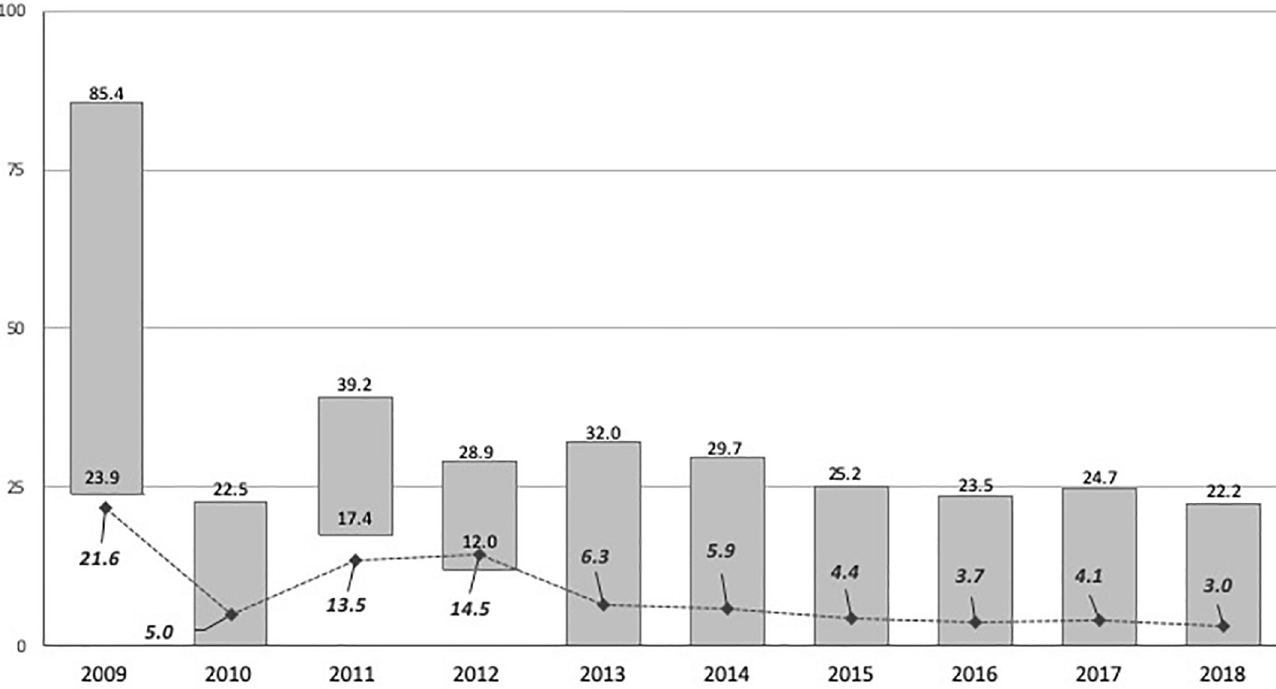
PLOS ONE | https://doi.org/10.1371/journal.pone.0245491 January 15,